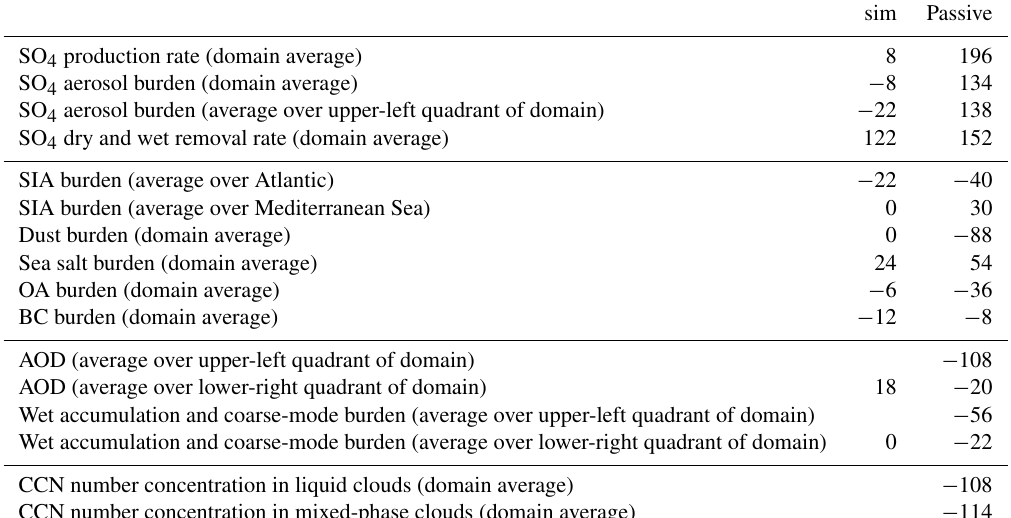
Table 5. Horizontal averages of relative differences. (cid:49) = 2 ( M7 − MADE )/( M7 + MADE ) between MADE and M7 in percent for sim and Passive simulations. Values correspond to Figs. 3, 4, 8, 9 and 10, where production rates are vertically integrated and concentrations are vertically averaged. With the exception of secondary inorganic aerosol (SIA, see text) and accumulation and coarse-mode burden, aerosol burden and SO 4 production and removal are not illustrated for the Passive simulation. AOD (aerosol optical depth) and CCN are not shown for sim simulation. If not explicitly stated otherwise, aerosol burdens correspond to dry aerosol mass. OA: organic aerosol. sim